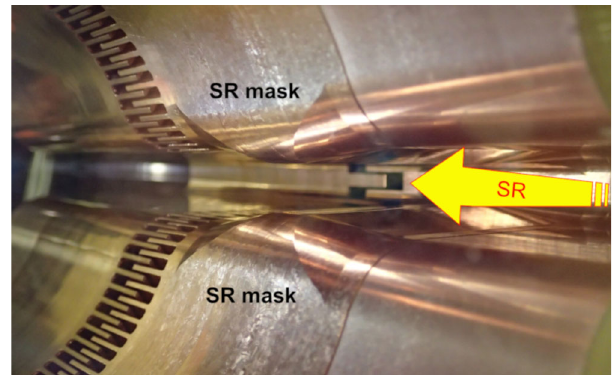
FIG. 33. (a) Beam pipe at the downstream of Oho wiggler section and (b) spray of liquid sealant into the